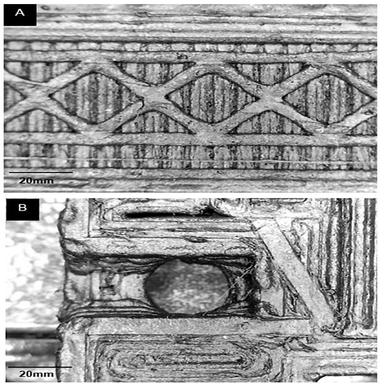
Complex 3D deposition patterns formed to improve structural integrity and reduce weight of the structure (A) micrograph of a triangular lattice structure produced and (B) complex structure formation of a lateral horizontal hole structure produced.